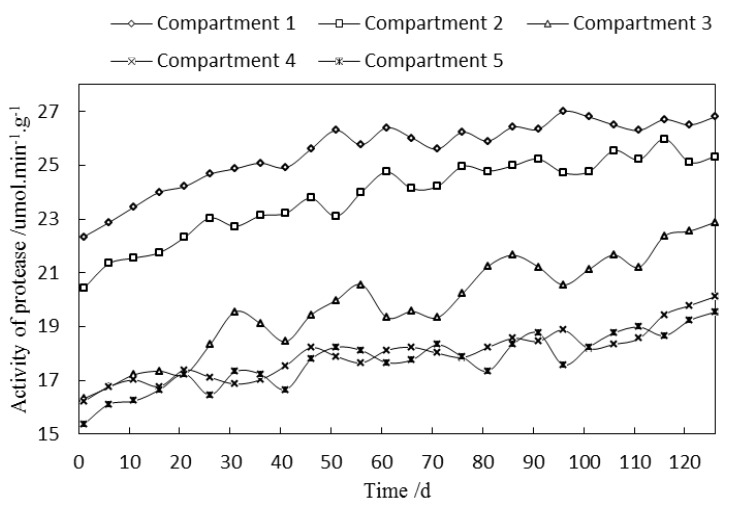
Figure 9. Variation in coenzyme F